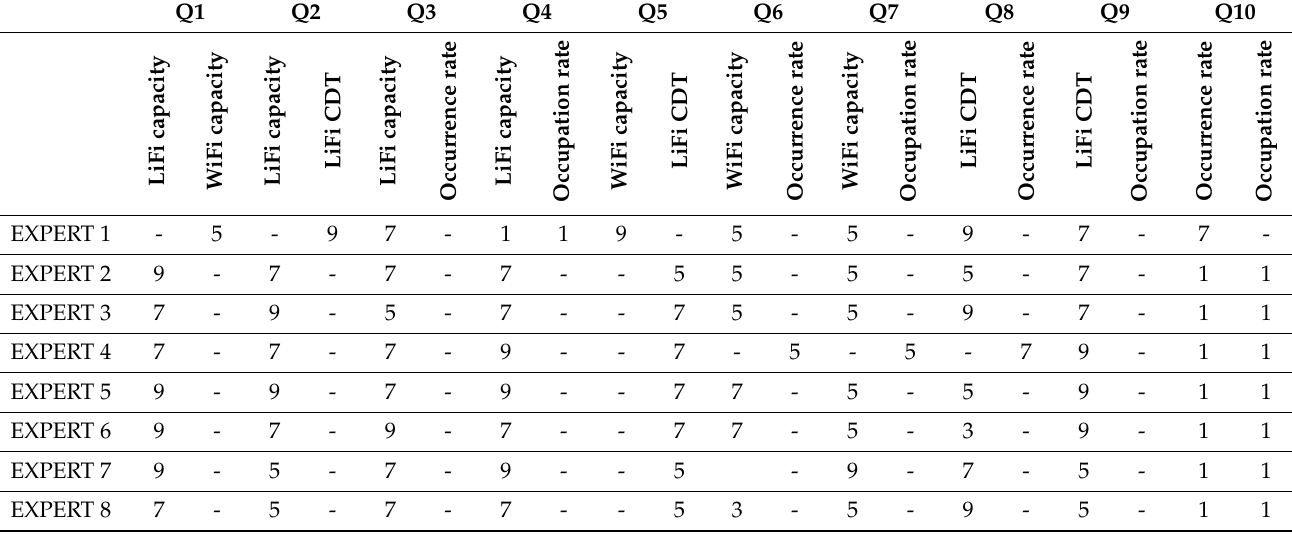
Table 15. CJ results obtained from the